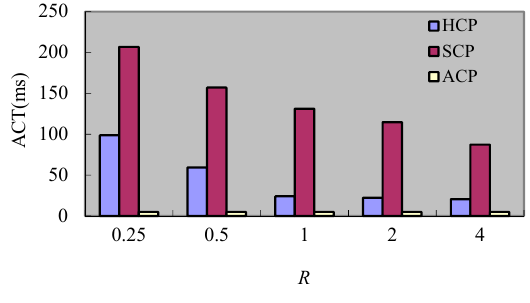
Figure 10. Impact of R on ACT.